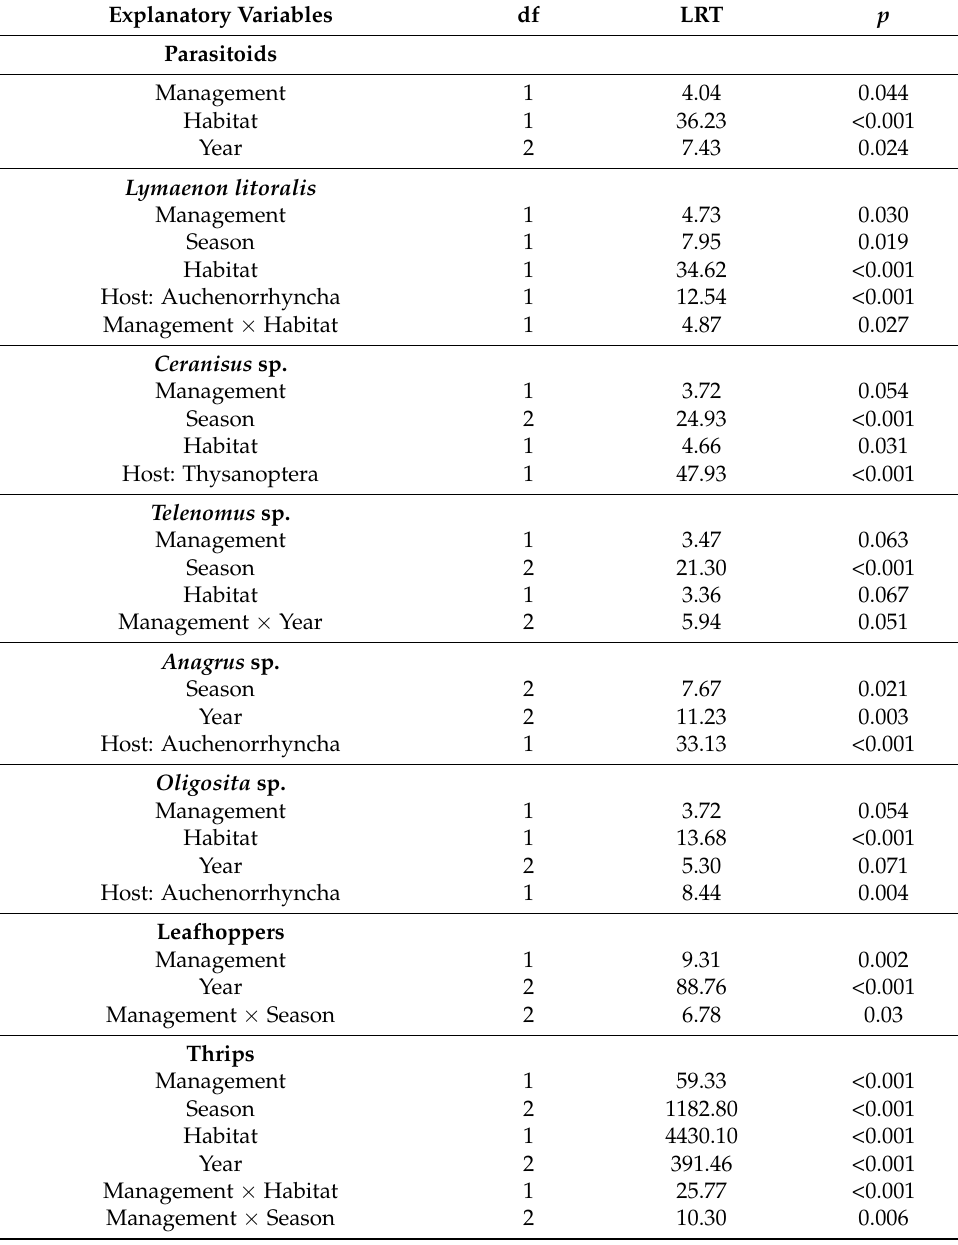
Table 1. Results from Linear Mixed Models showing the effect of explanatory variables on the abundances of all parasitoids, each of the five dominant parasitoid species/morphospecies, and two groups of potential hosts. Variables selected by maximum likelihood ratio tests with p < 0.1 are shown: df, degrees of freedom; LRT, likelihood ratio test